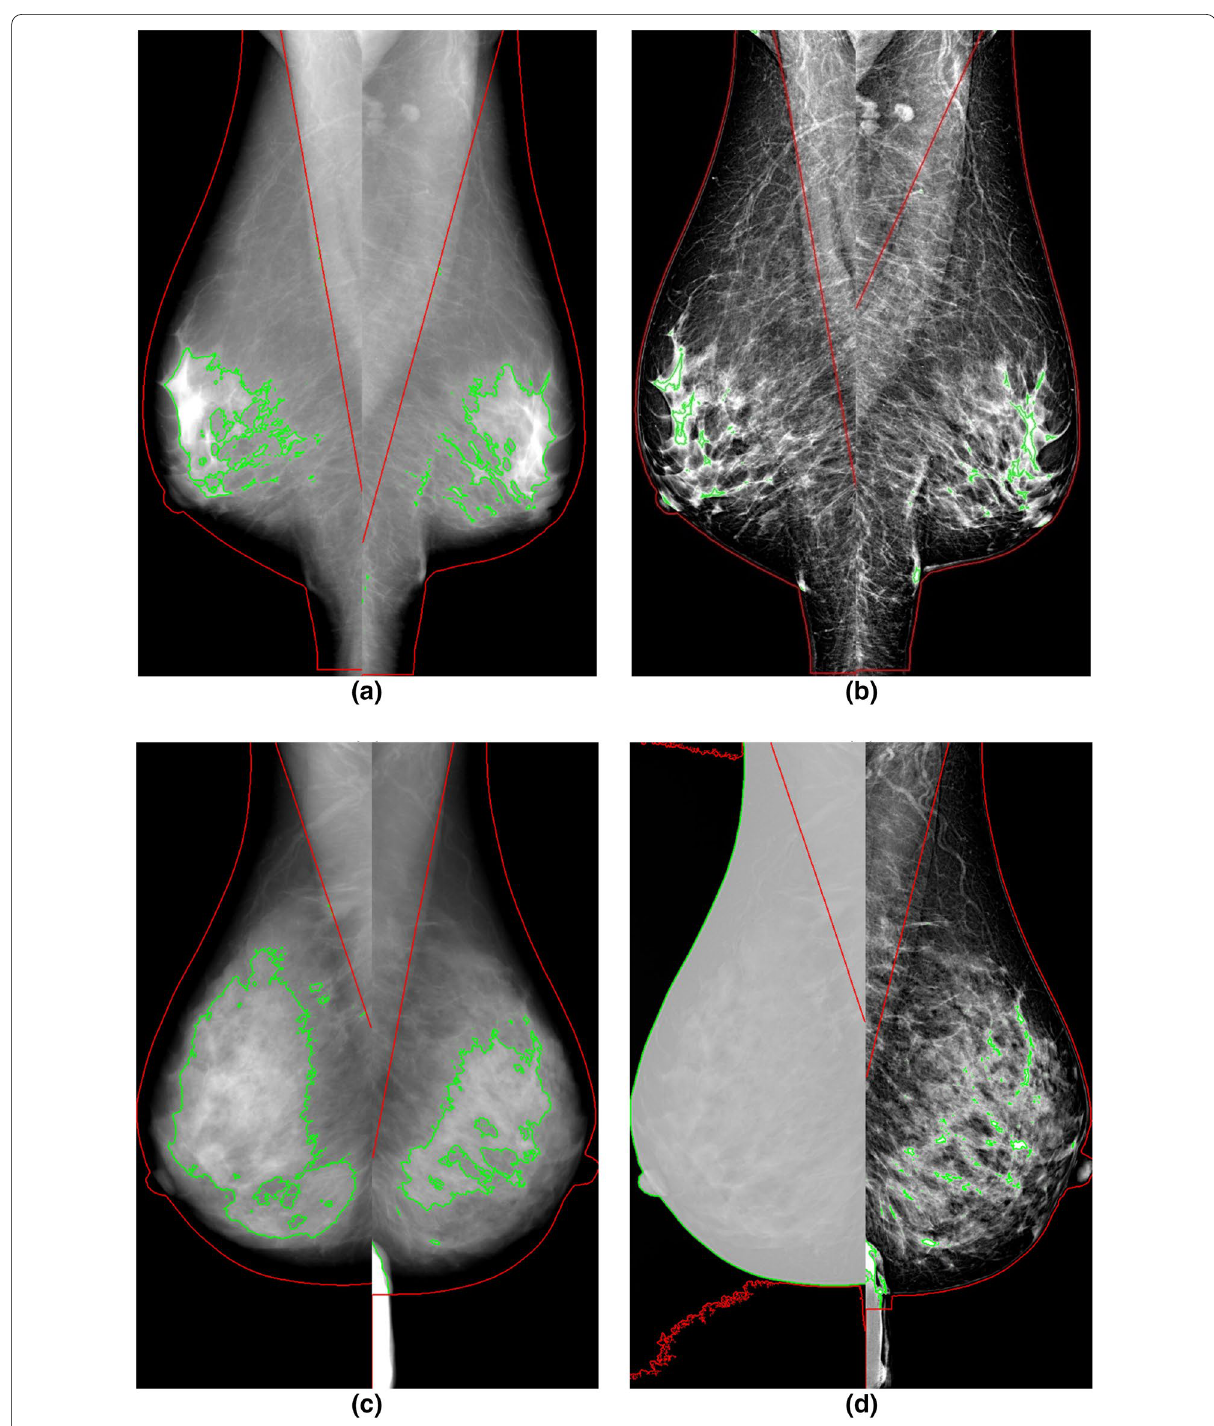
Fig. 1 Representative examples of segmentation of FFDM using LIBRA. a Segmentation using FOR PROCESSING images; b the same breasts segmented using FOR PRESENTATION images. In red the breast area; in green the dense area. There are large differences in the main breast area (pectoral muscle removal) and in the dense area. c , d An example from another woman representative of very large errors with consequently wrong Percent Density